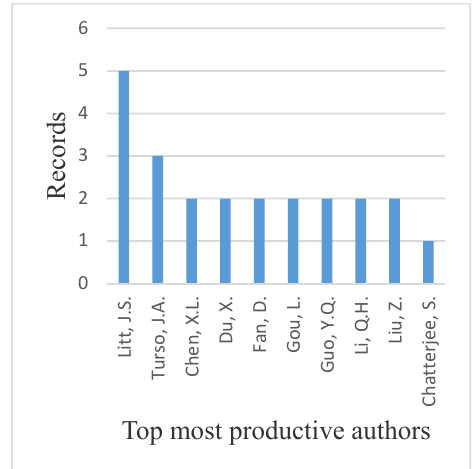
Figure 10. List of the top 10 scientific institutes in terms of published articles.